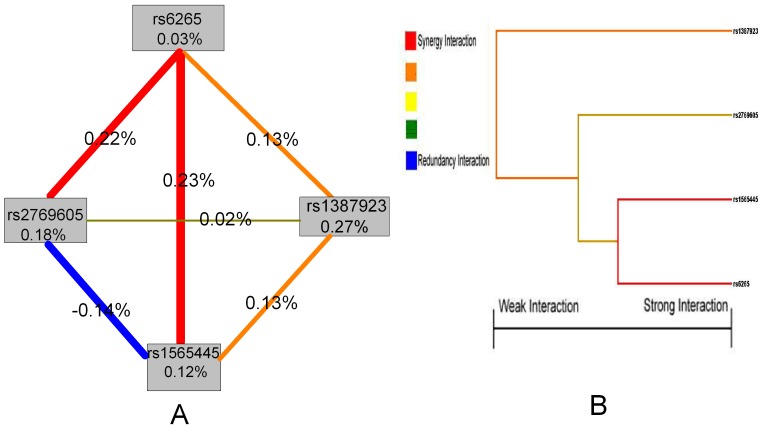
Hierarchical interaction graphs and interaction dendrogram.(A) Hierarchical interaction graphs showed that the percentage at the bottom of the each polymorphism represented entropy of it, and the percentage on each line represented the interaction percentage of entropy between two polymorphisms. The red line represented synergy redundancy interaction and the blue line represented redundancy interaction. (B) Interaction dendrogram showed that the red line represented synergy interaction and the orange line represented synergy interaction more weakly. From left to right the interaction was more intensive.